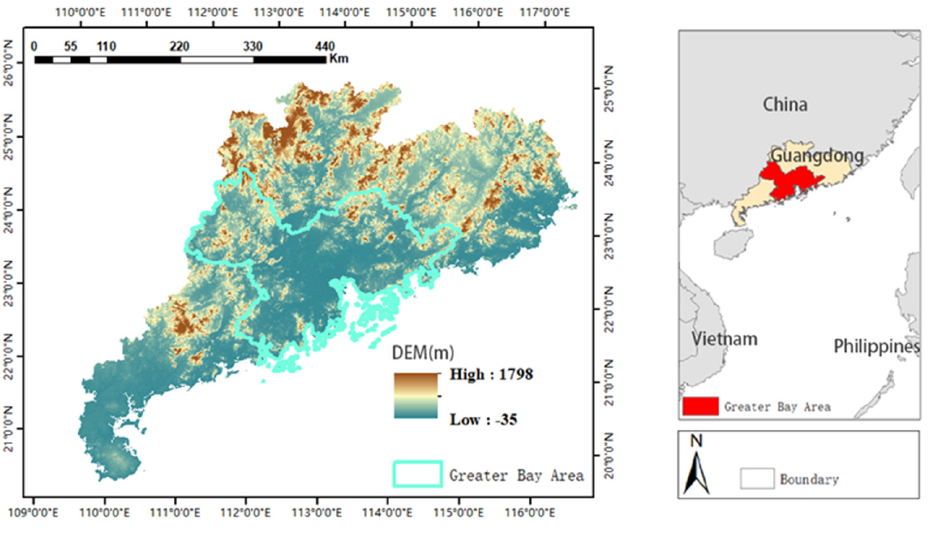
Figure 1. Location and DEM of the study areas.